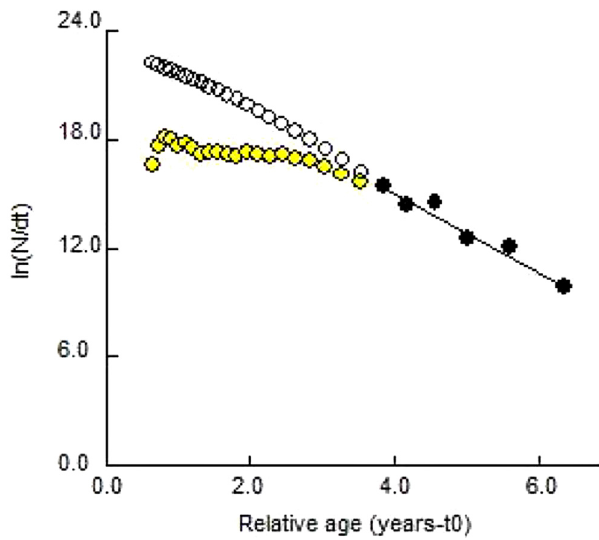
Fig. 5. Length converted catch curve for the estimation of mortality of S. undosquamis from southeastern Arabian Sea.